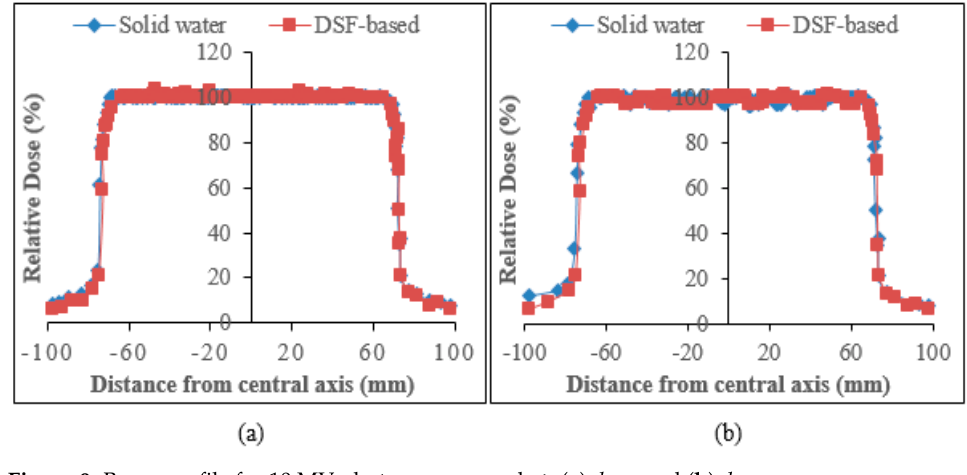
Figure 8. Beam profile for 6 MV photons evaluated at: ( a ) 𝑑 (cid:3040)(cid:3028)(cid:3051) and ( b ) 𝑑 (cid:3045)(cid:3032)(cid:3033) .